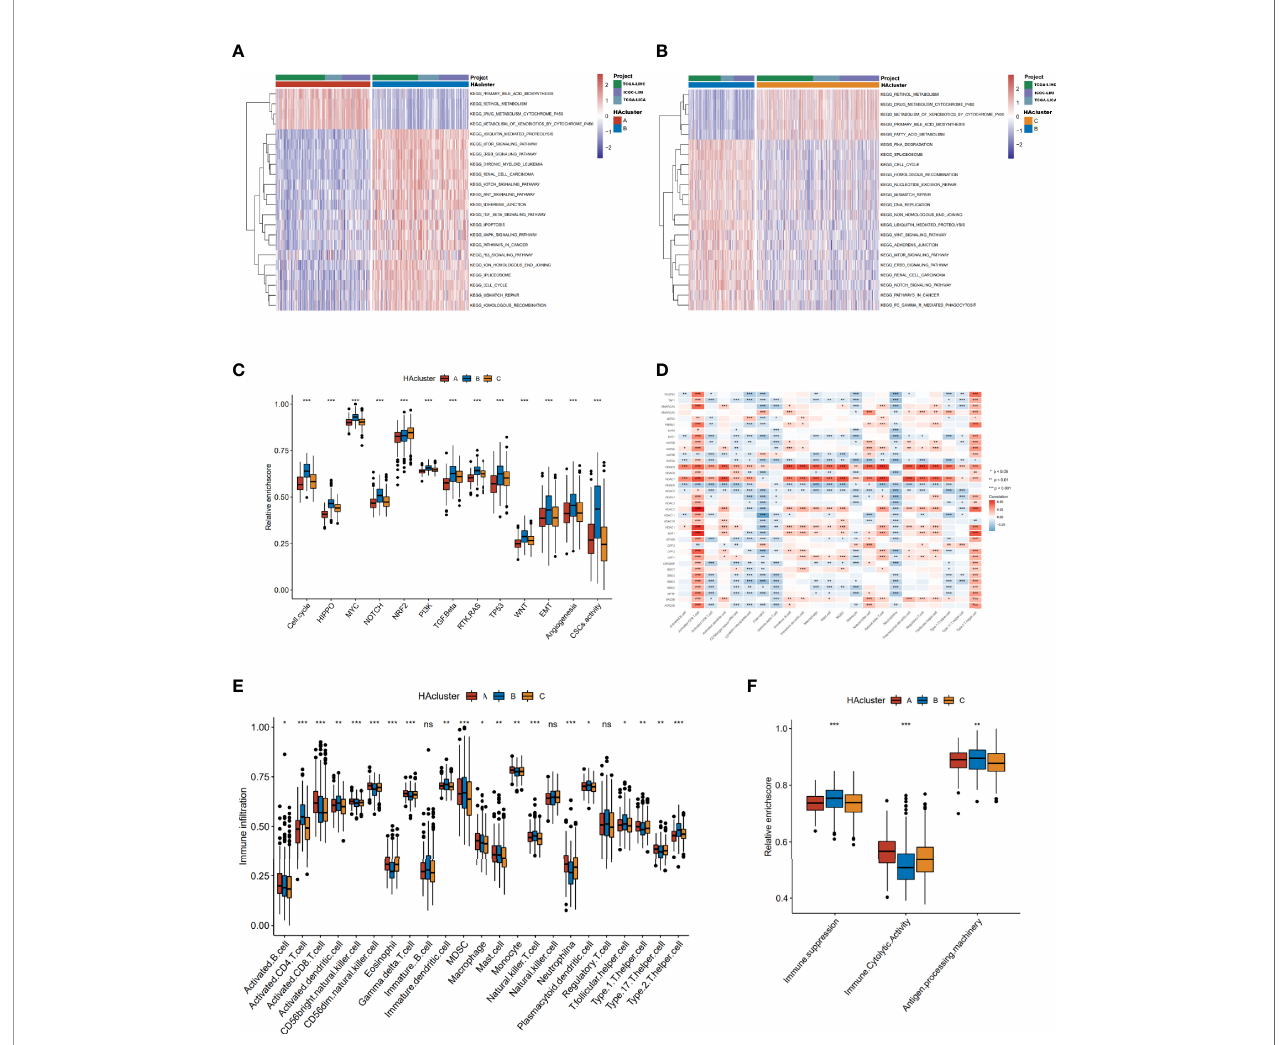
FIGURE 3 | Biological characteristics of histone acetylation patterns. (A, B) GSVA enrichment analysis demonstrates the activation states of KEGG biological pathways between distinct HAclusters in RNA-seq meta cohort and the activated group visualized by heatmap. Yellow and blue represent activated and inhibited pathways, respectively. The HAcluster and project of database were used as sample annotations. (A) HAcluster A vs HAcluster B; (B) HAcluster B vs HAcluster (C) Differences in oncogenic pathways among the three distinct HAclusters. (D) The correlation between the 36 histone acetylation regulators and TME in fi ltration cells in RNA-seq meta cohort. Positive and negative correlations are marked in red and blue, respectively. (E) Boxplot of abundance of TME-in fi ltrating cells in three HAclusters, based on the RNA-seq meta cohort. (F) Differences in immune-related functional pathways among the three distinct HAclusters. The statistical differences among the three HAclusters were tested by the Kruskal – Wallis test. (* P < 0.05; ** P < 0.01; *** P < 0.001; ns, non-signi fi